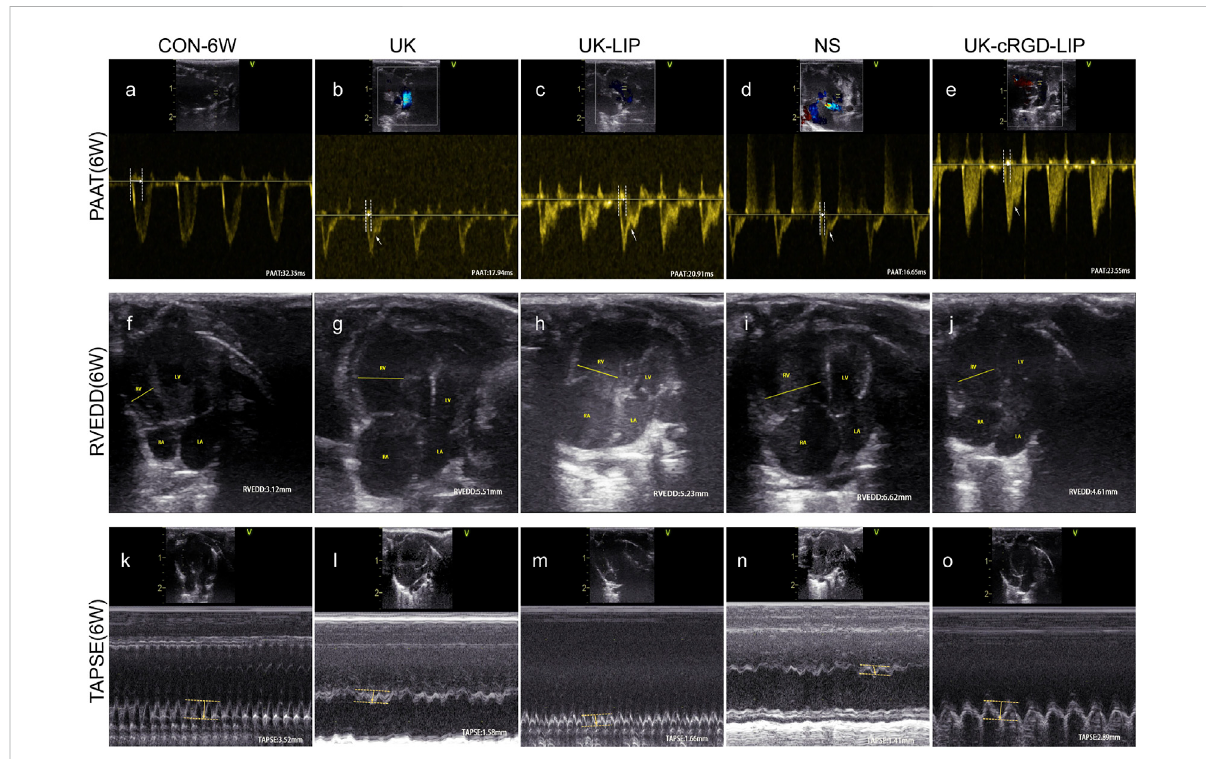
FIGURE 8 Representative echocardiography imagesofCON-6W,UK,UK-LIP,NSandUK-cRGD-LIPrats. (A – E) PAAT: Pulse-wave Dopplerofviewsatthe parasternal short-axis section. White arrow pointed to midsystolic notching. (F – J) RVEDD: Apical four-chamber view. Yellow line highlighted right ventricle internal diameter during diastole. (K – O) TAPSE: Tricuspid annular plane systolic excursion was recorded by M-mode echocardiography. Yellow arrow represented distance. Abbreviations: RV, right ventricular; LV, left ventricular; RA, right atrium; LA, left